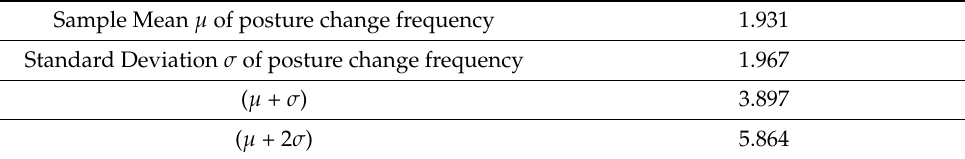
Table 4. Sample mean and standard deviation.